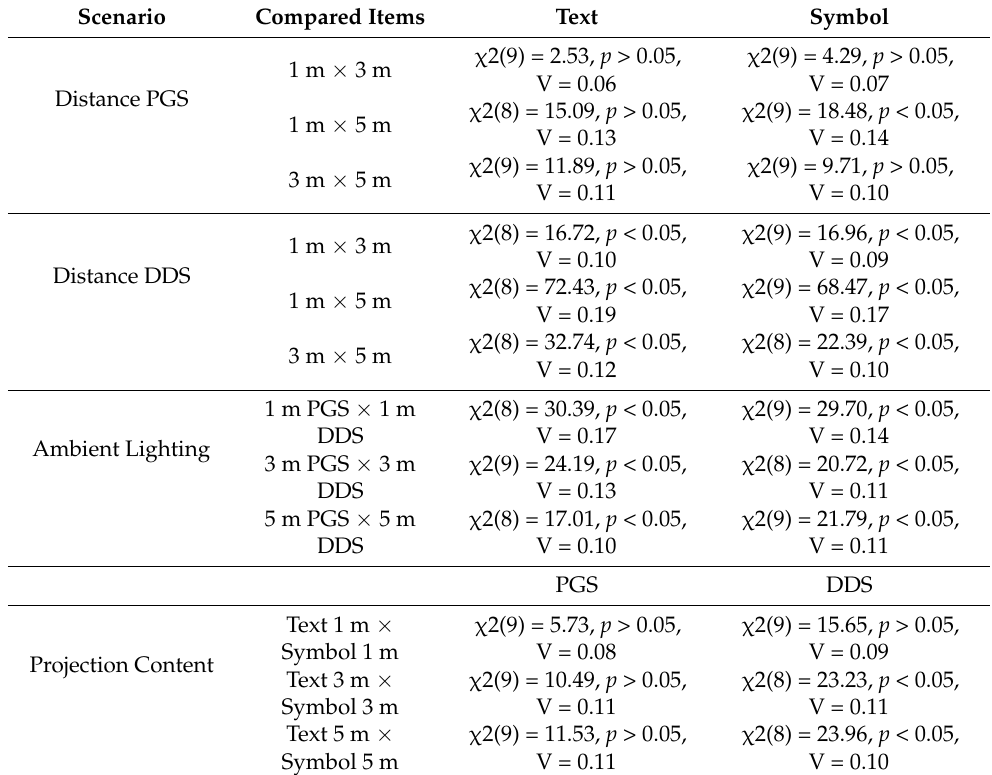
Table 1. Effects of viewing distance, ambient lighting and projection content statistically analyzed with a chi-square test and the corresponding effect size (Cramer’s